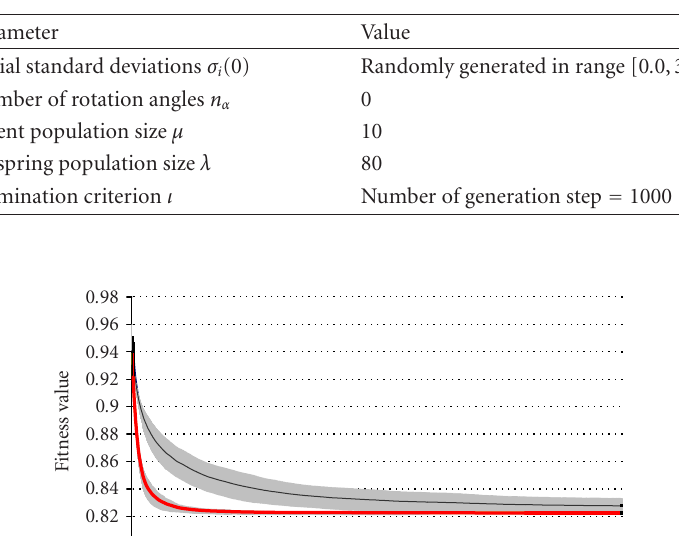
Table 1: Setting of exogenous parameters of the ES.